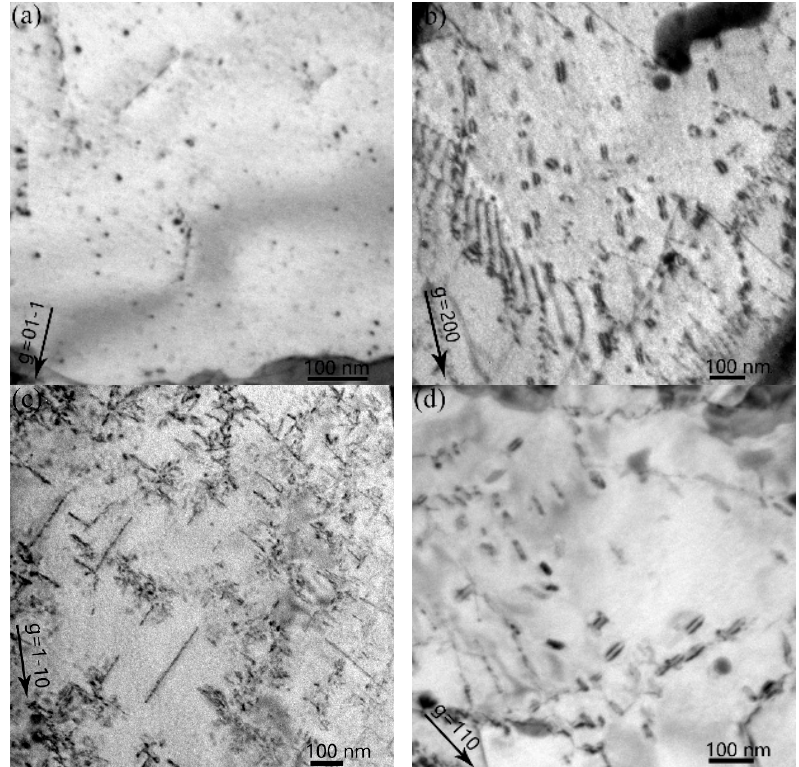
Figure 2. TEM bright field micrographs of specimens irradiated with H + to the fluence of 5 × 10 20 H + • m − 2 at elevated temperature (( a ) 523 K, g = 01-1 near the pole [011]; ( b ) 623 K, g = 200 near the pole [001]; ( c ) 723 K, g = 1–10 near the pole [001]; ( d ) 823 K, g = 110 near the pole [001]). In Figure 2b, when the temperature increased to 623 K, larger loops with an average size of 34.0 nm and density of 1.1 × 10 21 m − 3 ( g = 110) were observed. When irradiated at 723 K, loops with an average size of 93.6 nm and density of 1.7 × 10 21 m − 3 ( g = 1 – 10) were observed. Among all of the irradiation temperatures, the loops had the largest average size at 723 K. However, the dislocation loops with a mean size of 36.0 nm and a number density of 7.9 × 10 20 m − 3 ( g = 110) became smaller at a temperature of 823 K. At 623–823 K, all of the loops had the Burgers vectors of b = a 0 <100>. 3.2. Dislocation Loop Evolution in RAFM Steel with Increasing Hydrogen Fluence Figure 3 shows the micrographs of the dislocation loops after hydrogen irradiation at 1 × 10 20 H + • m − 2 (0.03 dpa) to 5 × 10 20 H + • m − 2 (0.16 dpa), at a temperature of 723 K. At 1 × 10 20 H + • m − 2 , no dislocation loops were observed in the specimens. However, when the irradiation fluence increased to 2 × 10 20 H + • m − 2 , small loops with a mean size of 4.3 nm and density of 6.6 × 10 22 m − 3 ( g = 110) were observed. When the irradiation fluence was further increased from 3 × 10 20 H + • m − 2 to 5 × 10 20 H + • m − 2 , the average size and density of the loops increased from 22.9 nm to 93.6 nm and 8.1 × 10 21 m − 3 to 1.7 × 10 21 m − 3 ( g = 110), respectively. At 723 K, all of the loops were determined to be b = a 0 <100>.